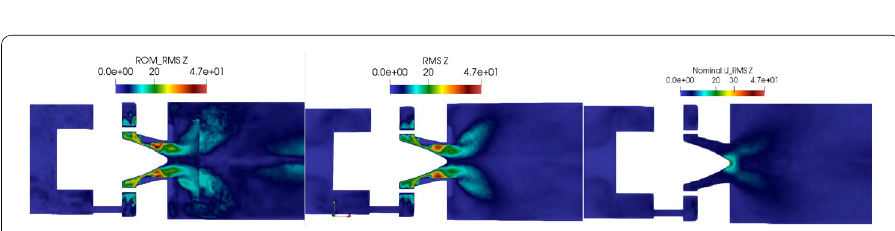
Fig. 45 On the left, the second component of the root mean square flow field by the UGPOD applied to configuration 1. In the middle, the second component of the high fidelity root mean square flow field with configuration 1. On the right, the second component of the high fidelity root mean square flow field with the nominal configuration